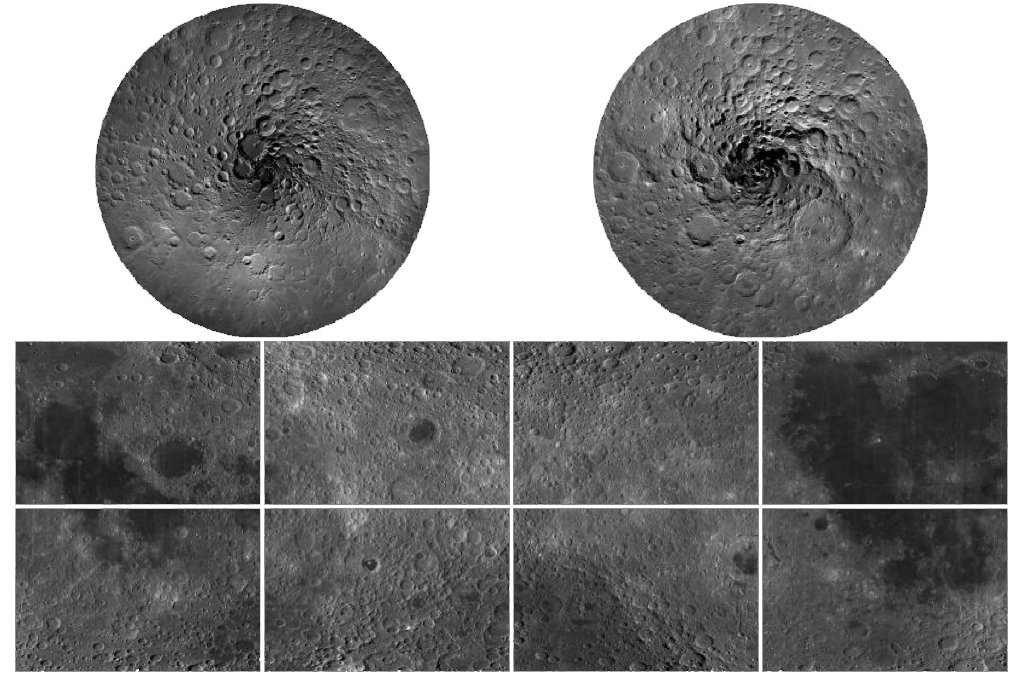
Figure 1. LROC WAC global mosaic consist of eight equirectangular tiles that encompass 60° latitude by 90° longitude and two polar stereographic tiles that cover 60° to the respective pole.